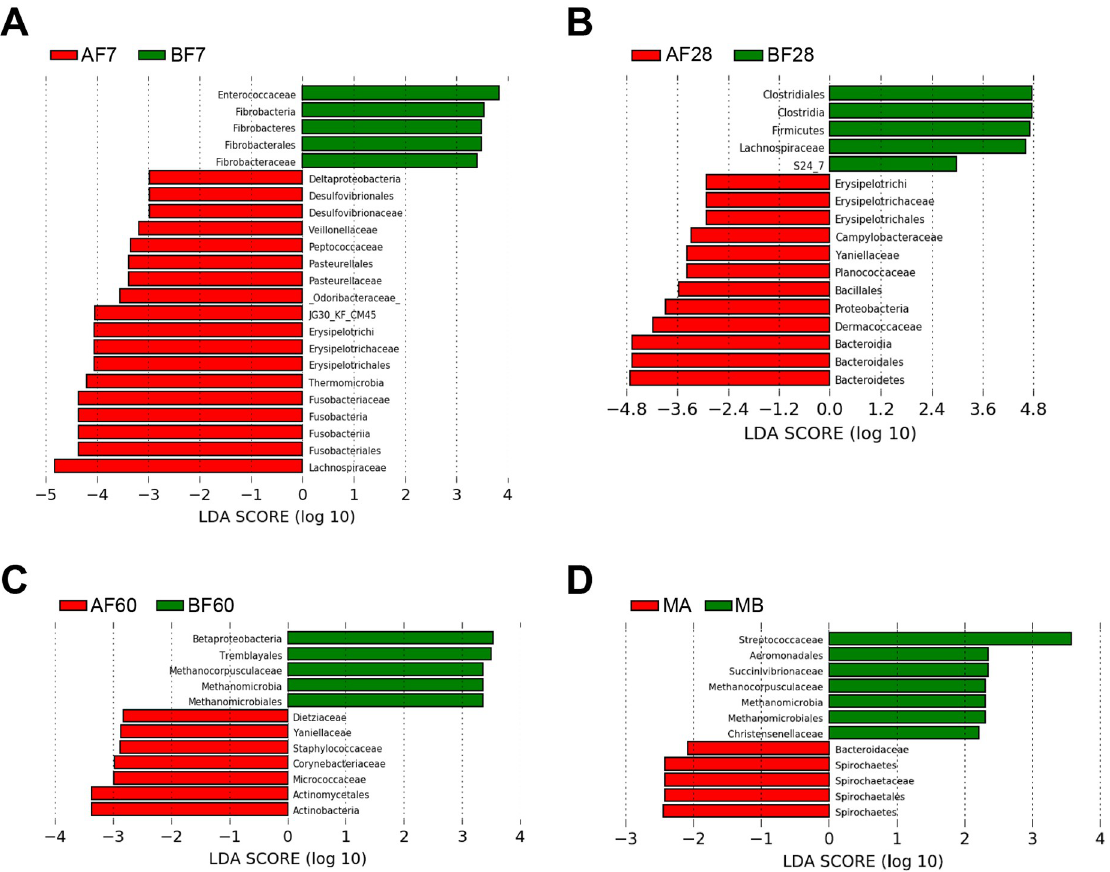
Fig 6. LEfSe distinguishes which bacterial populations are relatively abundant between healthy samples at Farm A and Farm B at different time points. Specifically, we examined (A) Day 7, (B) Day 28, (C) Day 60, and (D) mare samples at Day 1. Significant differences were found by Kruskal-Wallis (KW) rank-sum test, and reported in log 10